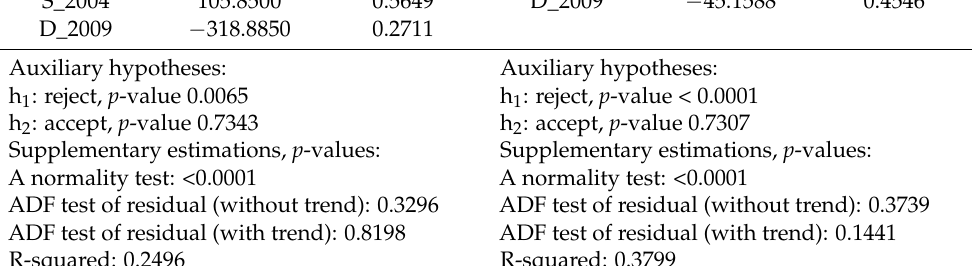
Table 8. Non-linear autoregressive distributed lag (NARDL) estimations for panel data of all three Baltic countries. Variable Coefficient p -Value Variable Coefficient p -Value Using NU and GV: Using LU and GV: Constant 833.8770 0.0046 Constant 191.2130 0.0024 NU ( − 1) − 0.1451 0.0122 LU ( − 1) GV ( − 1) −